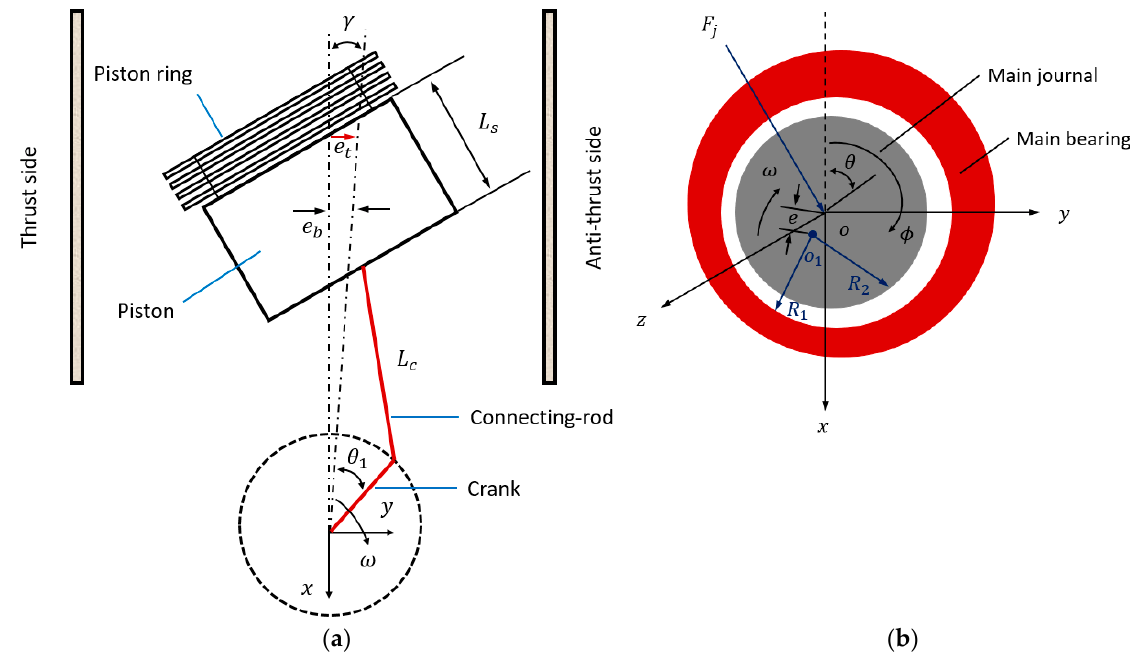
Figure 14. Schematic of the piston–crankshaft system: ( a ) piston-cylinder; ( b ) main bearing–journal system [2].